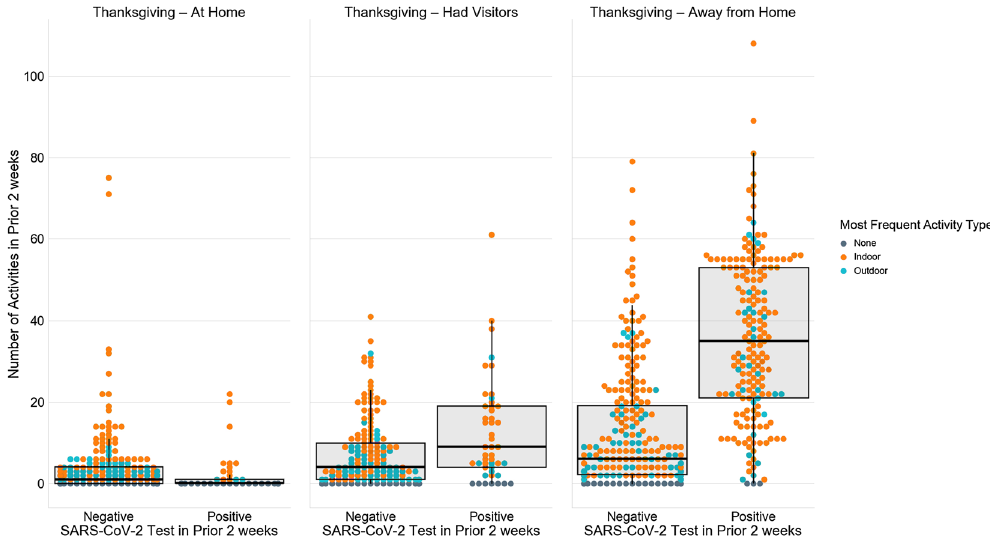
Figure 1. Summary of non-essential activities in the prior 2 weeks by Thanksgiving travel and SARS-CoV-2 test positivity in the prior 2